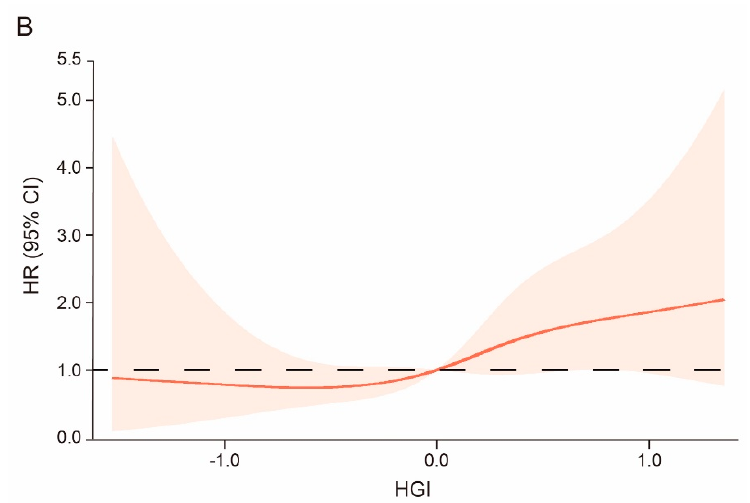
Figure 4. The RCS of HGI levels and incident stroke risk grouped by DM status. The HGI had a linear correlation with the risk of onset stroke, in which higher HGI could increase the risk of incident stroke. Meanwhile, even in the subjects without DM, high HGI still could increase the risk of incident stroke. ( A ). The RCS of HGI and risk of incident stroke in non-DM participants, n = 2620; ( B ). The RCS of HGI and risk of incident stroke in DM participants, n = 314. Abbreviations: HR, hazard ratio; CI, confidence interval; HGI, glycated hemoglobin index.